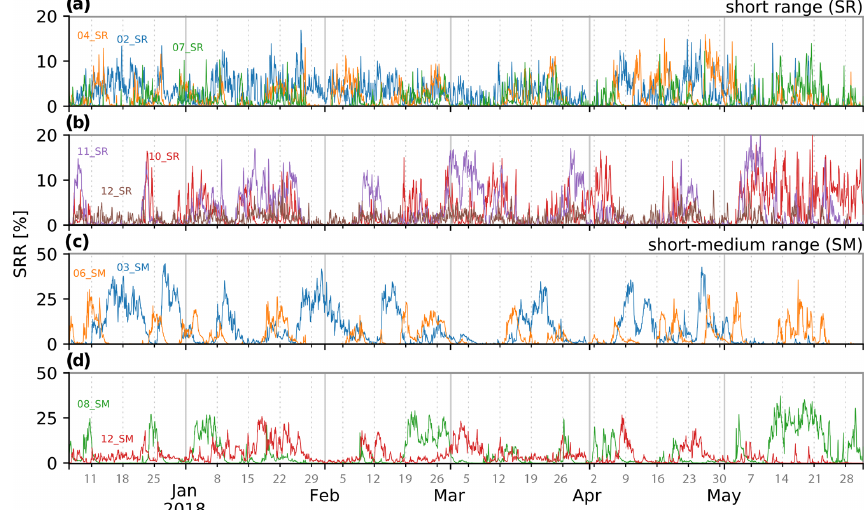
Figure 11. Time series of the SRR [%] cluster influence from 6 December 2017 until 31 May 2018. Panels (a) and (b) show the SR clusters, and (c) and (d) show the SM clusters. Note the different y axis between panels (a) and (b) and (c) and (d)